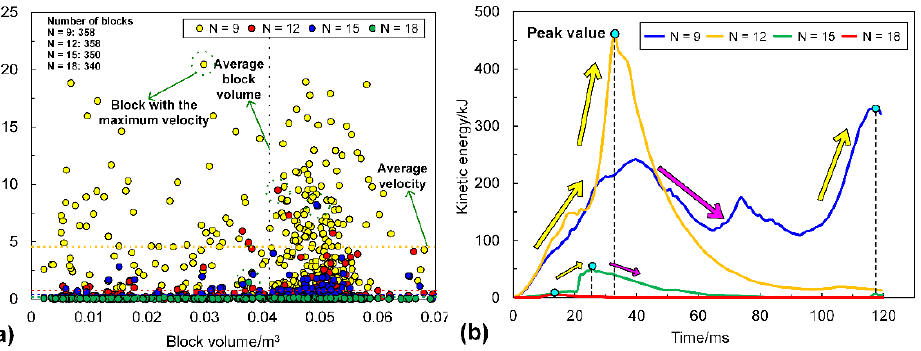
Figure 20. ( a ) is the velocity of all detached blocks versus block volume. ( b ) is the evolution of kinetic energy of ejected rock blocks in the tunnel. N is the bolt number.